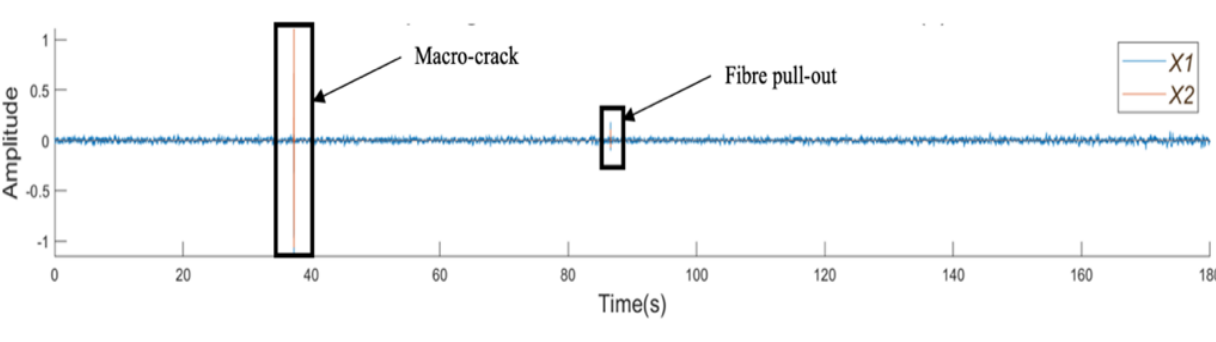
Figure 5. Amplitude vs. time plots for the plain SCC beam: ( a ) the complete test, ( b ) the section highlighting the microcrack, and ( c ) the section highlighting the macrocrack.